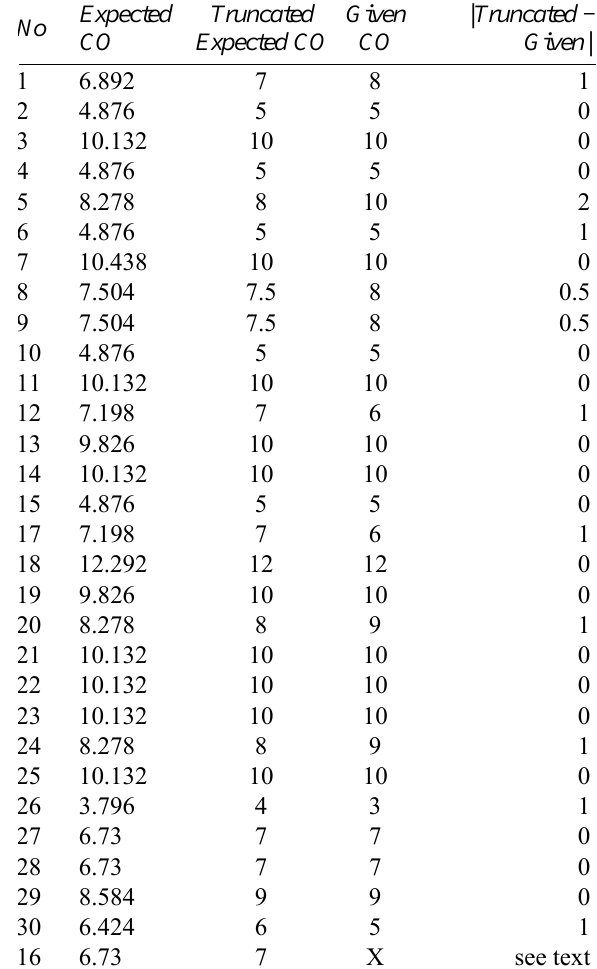
Table 4: Cigarette chemical composition: given vs.